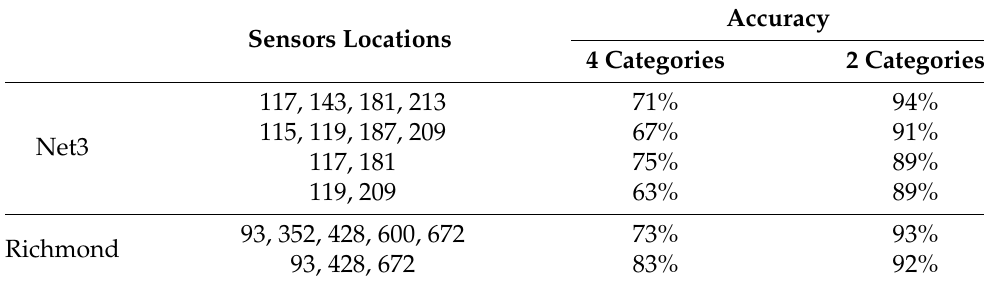
Table 5. Influence of sensor layout for Net3 and Richmond networks on prediction model